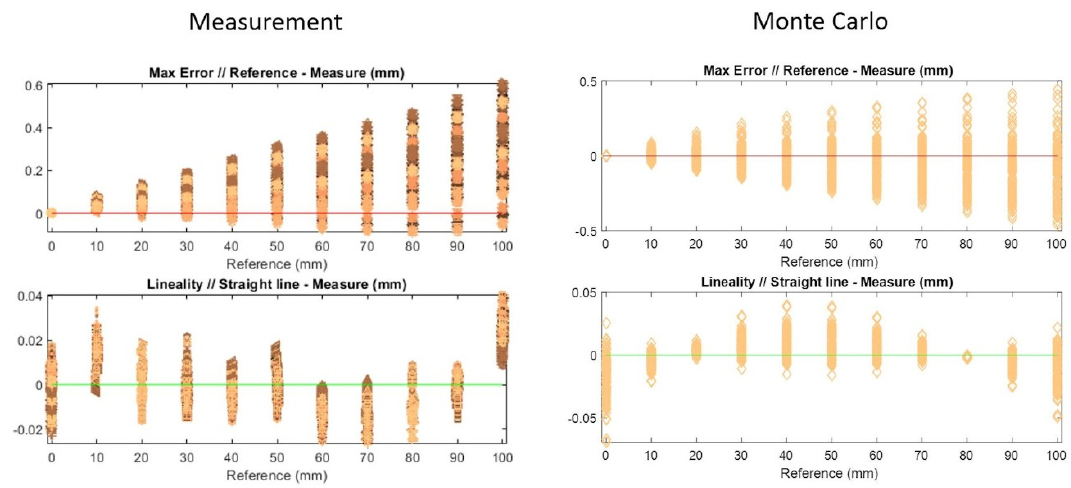
Figure 13. Comparative measurements between experimental and Monte Carlo analysis, with similar shapes obtained for maximum error and linearity.